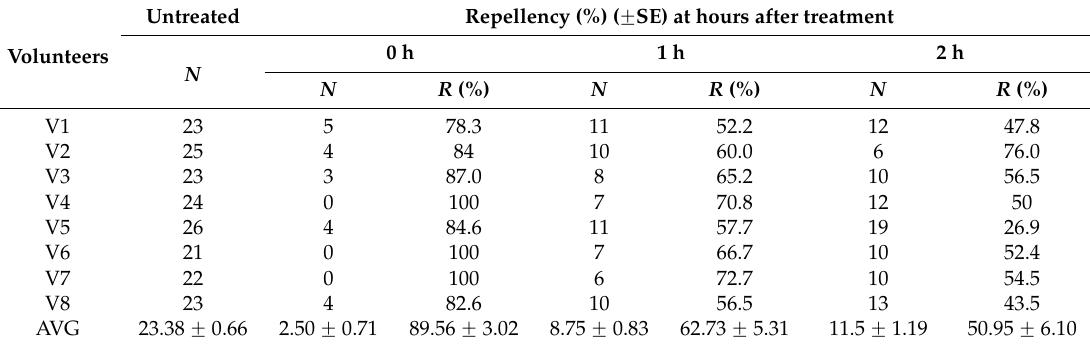
Table 3. Repellency of 5% citral against Aedes albopictus in laboratory